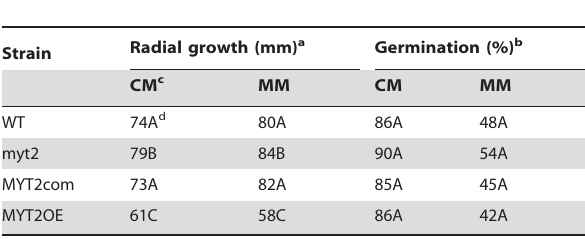
Table 3. Radial growth and germination